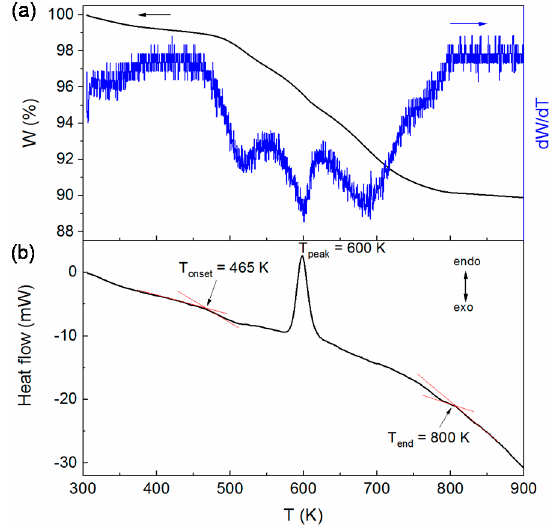
Figure 4. ( a ) TGA and dW/dT curves, ( b ) DSC curve of the α″ -Fe 16 N 2 @C nanocones recorded in the heating process in a temperature range between 300 and 900 K.